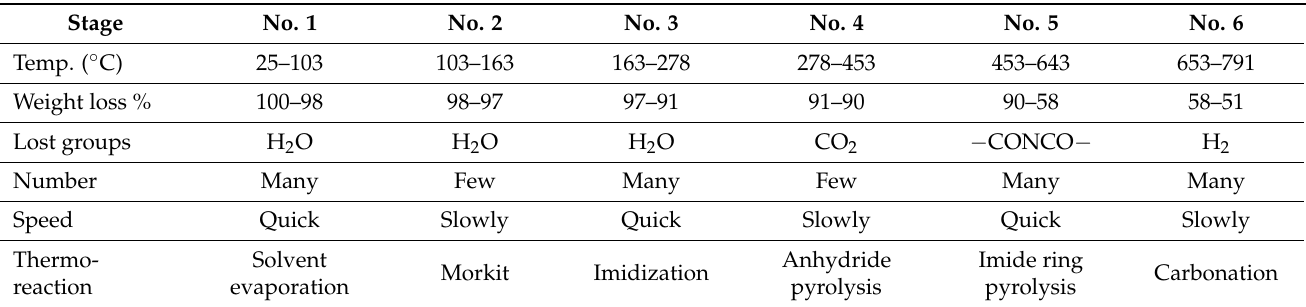
Figure 4. TGA thermograms of PABB resin. Table 3. TGA results of PABB resin.